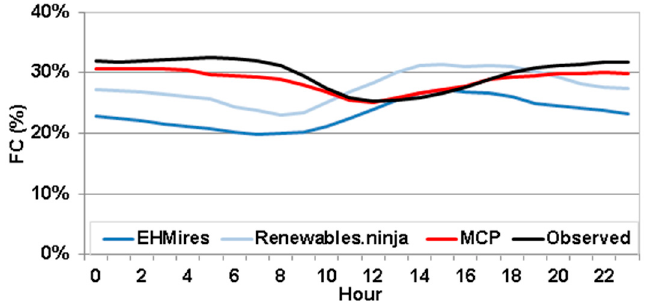
Figure 1. Daily average wind power capacity factor during January 2014 and December 2015. Adapted from [24].